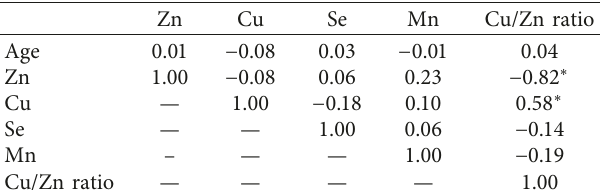
Table 7: Spearman’s rank correlation coefficients for myopic patients.